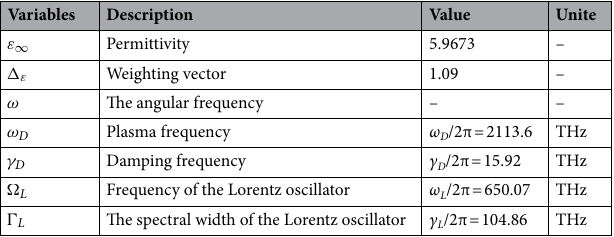
Table 1. The variables of Drude-Lorentz model for gold layer of Eq. (2) 27 .